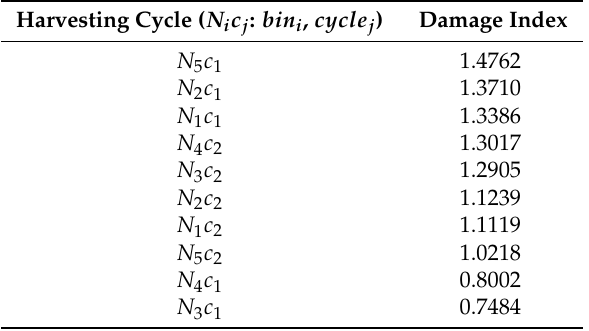
Table 1. Experimental campaign: Harvesting cycles ordered in terms of potential fruit damage.